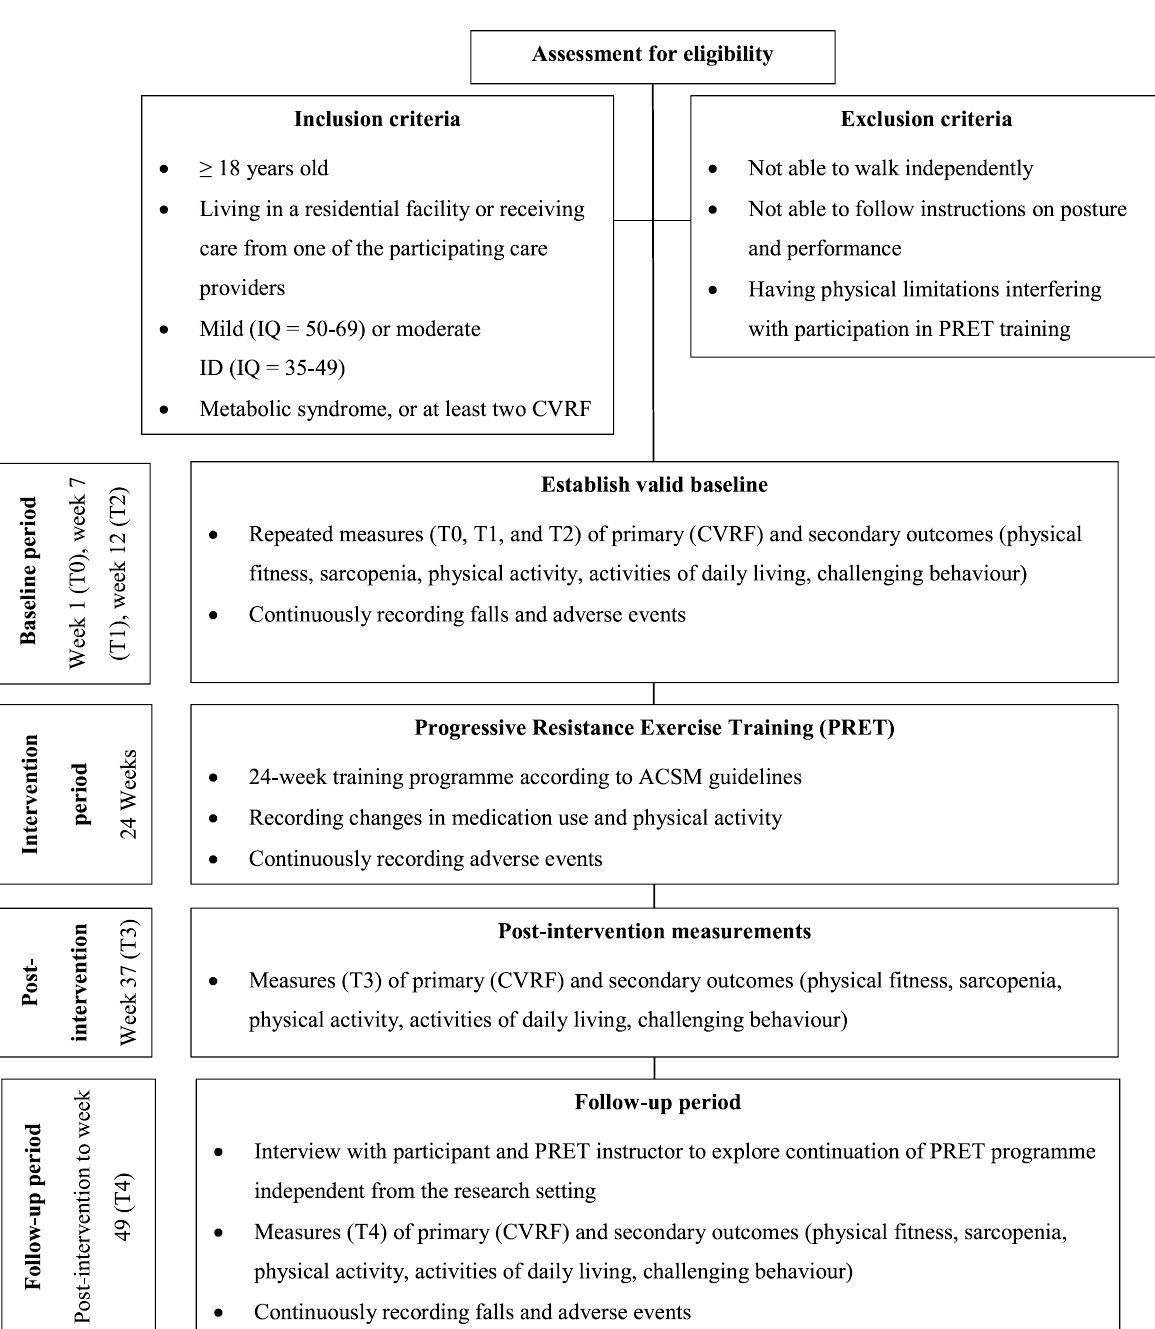
Figure 1. Study recruitment and procedures. ACSM: American College of Sports Medicine; CVRF: cardiovascular risk factors; ID: intellectual disability IQ: intelligence quotient.